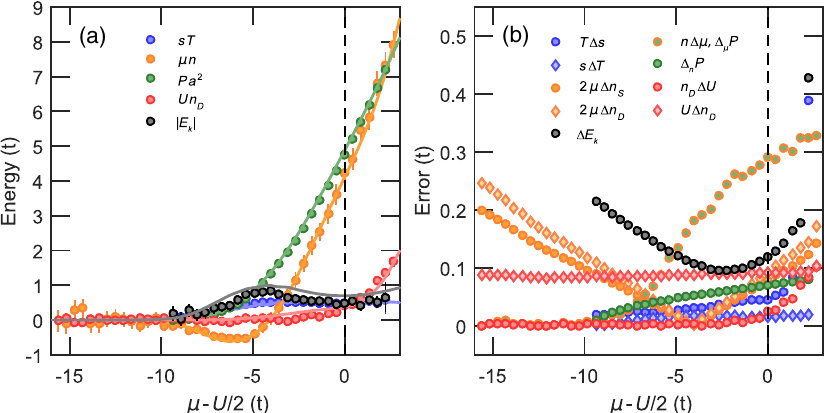
FIG. 5. Average values (a) and uncertainties (b) of the individual terms contributing to the magnitude of the kinetic energy j E k j . Note that in the calculation of the error of the kinetic energy Δ E k the term n Δ μ cancels with the pressure uncertainty Δ μ P concerning the uncertainty of the chemical potential. The term Δ n P denotes the pressure uncertainty due to the uncertainty of the density n . The solid lines show the theoretical expectation of the individual terms obtained from NLCE data of the two-dimensional Hubbard model